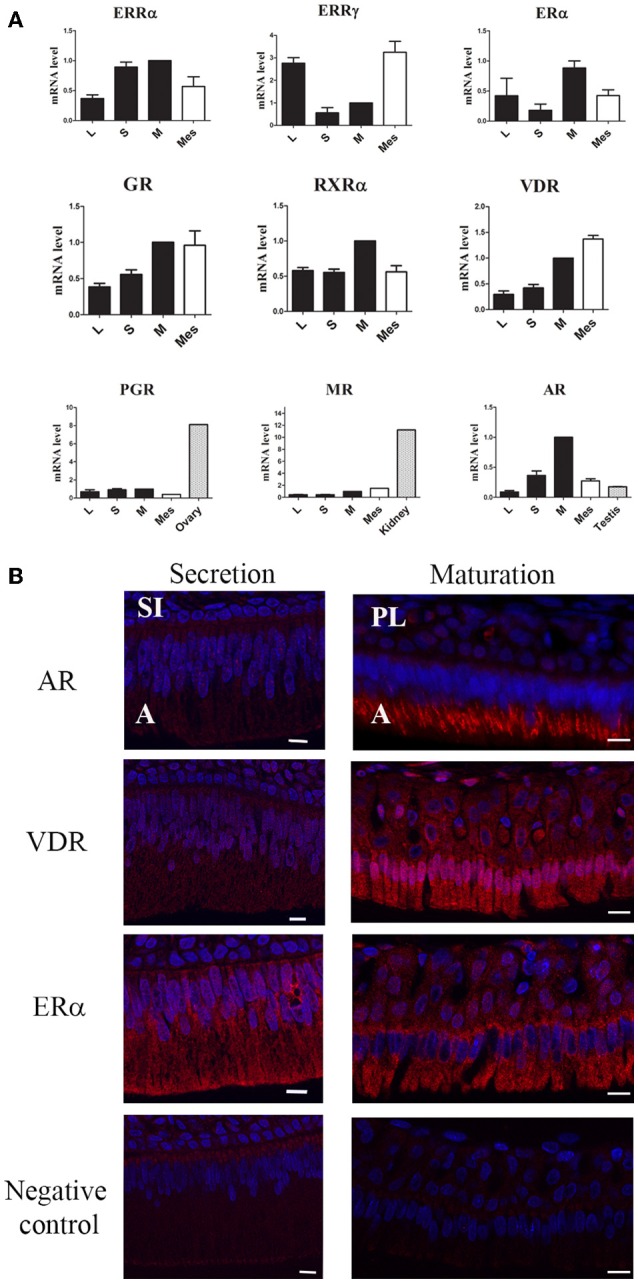
Specificity of steroid hormone and VD receptor expression in maturation-stage ameloblasts. (A) Expression levels calculated by the ΔΔCt method were compared between the cervical loop (L), secretion-stage cells (S), maturation-stage cells (M), mesenchymal cells (Mes) and other tissues used as references: testis for AR, kidney for MR, and ovary for PGR. The AR showed the most preferential expression in maturation-stage enamel tissue relative to all the other receptors tested with a level of expression even higher than that found in testis, used as the androgen responsive tissue. Results are from three independent analyses of three RNA samples of each tissue and are presented as the means ± SD. (B) Immunofluorescent assays for the AR, ERα, and VDR, three receptors involved in amelogenesis. The ER signal was very low in all cells of the enamel organ. The signals corresponding to the AR and VDR were clearly localized in maturation-stage ameloblasts (involved in enamel terminal mineralization). The AR and VDR were also slightly detected in the secretion-stage. A, ameloblasts; PL, papillary layer; SI, stratum intermedium. Scale bars, 10 μm.